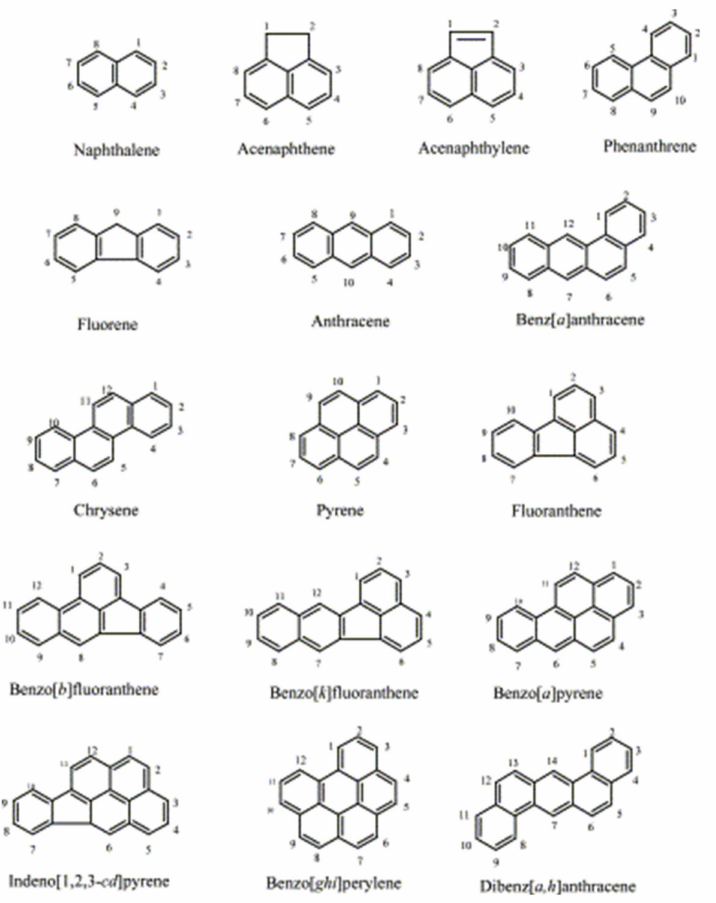
Figure 1. Structure formulas of the 16 analyzed PAHs (polycyclic aromatic hydrocarbons), adapted from [33,34].